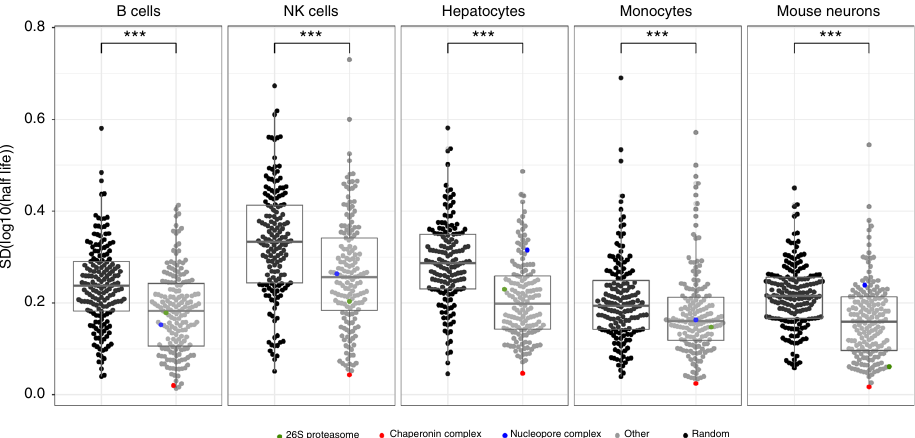
Fig. 3 Half-life variability among members of protein complexes is smaller than expected by chance. Distributions of standard deviations (SD) of half-lives from proteins in complexes as annotated in the CORUM database compared to SD of the half-lives of the same proteins shuf fl ed across the different complexes, while preserving the number of proteins in each complex group. Differences in the log 10 half-lives of true protein complex members vs. the random draws of proteins in a given cell type were assessed by Wilcoxon-rank test (signi fi cance levels were encoded as *** p < 0.001, ** p < 0.01, * p < 0.05). Center line in box plots is the median, the bounds of the boxes are the 75 and 25% percentiles i.e., the interquartile range (IQR) and the whiskers correspond to the highest or lowest respective value or if the lowest or highest value is an outlier (greater than 1.5 * IQR from the bounds of the boxes) it is exactly 1.5 *